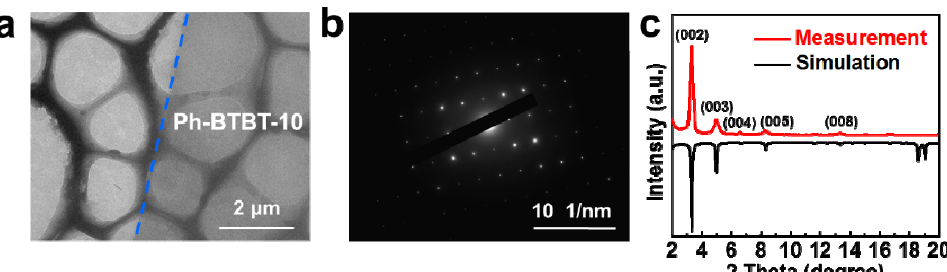
Figure 2. ( a ) Typical transmission electron microscope (TEM) image and ( b ) corresponding selected area electron diffraction (SAED) patterns of the crystalline film. ( c ) Measurement and simulation [28] of out-of-plane X-ray diffraction (XRD) patterns of the crystalline film. Efficient injection is a prerequisite for all high-performance optoelectronic devices.